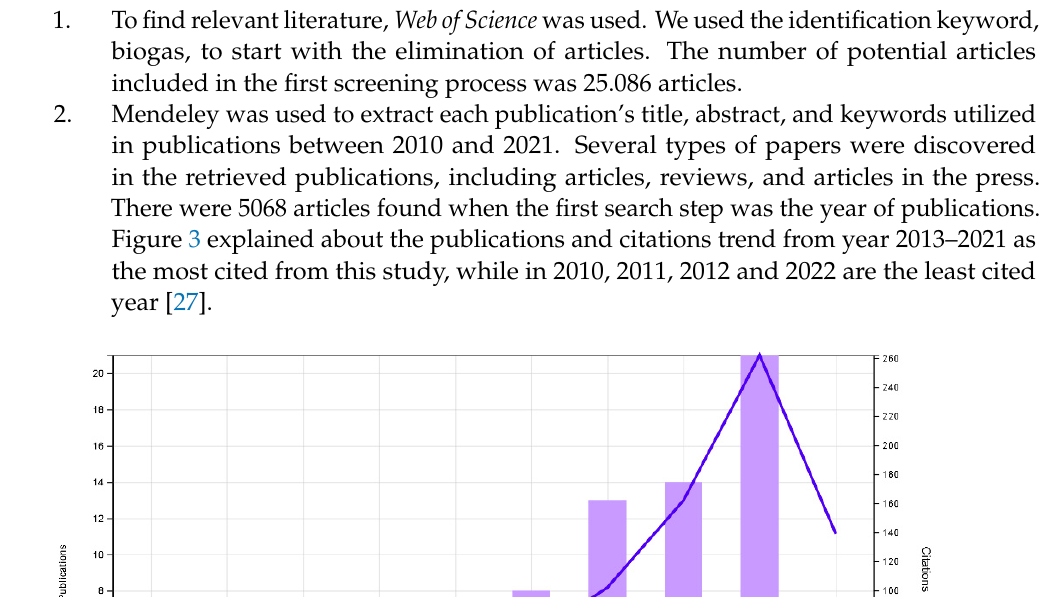
Figure 2. Procedures for conducting a literature review (developed by author, based on [24–26]).